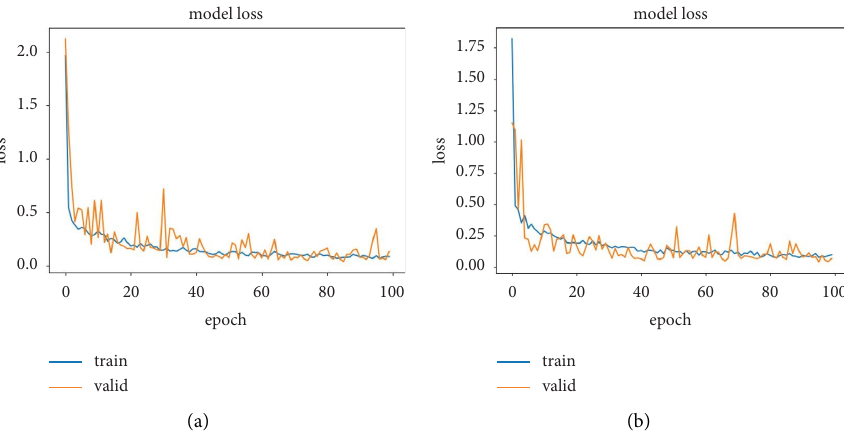
Figure 6: Loss curves of the training set and validation set: (a) loss curves of normal spectra, and (b) loss curves with outliers of spectra.